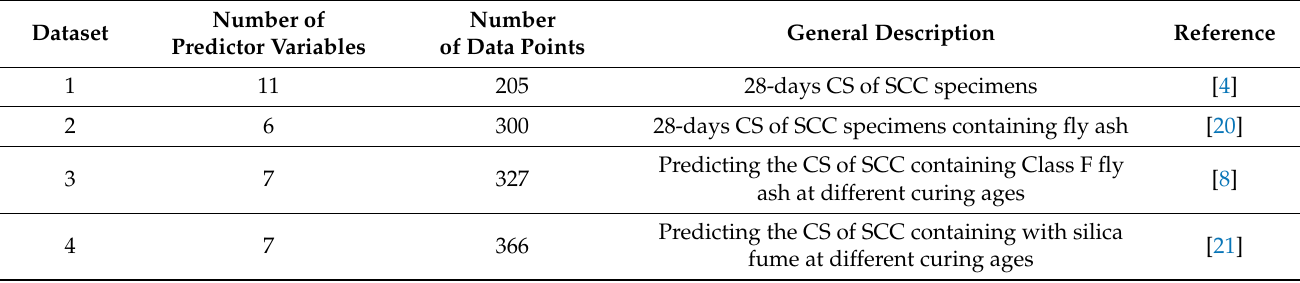
Table 1. The collected datasets of SCC.